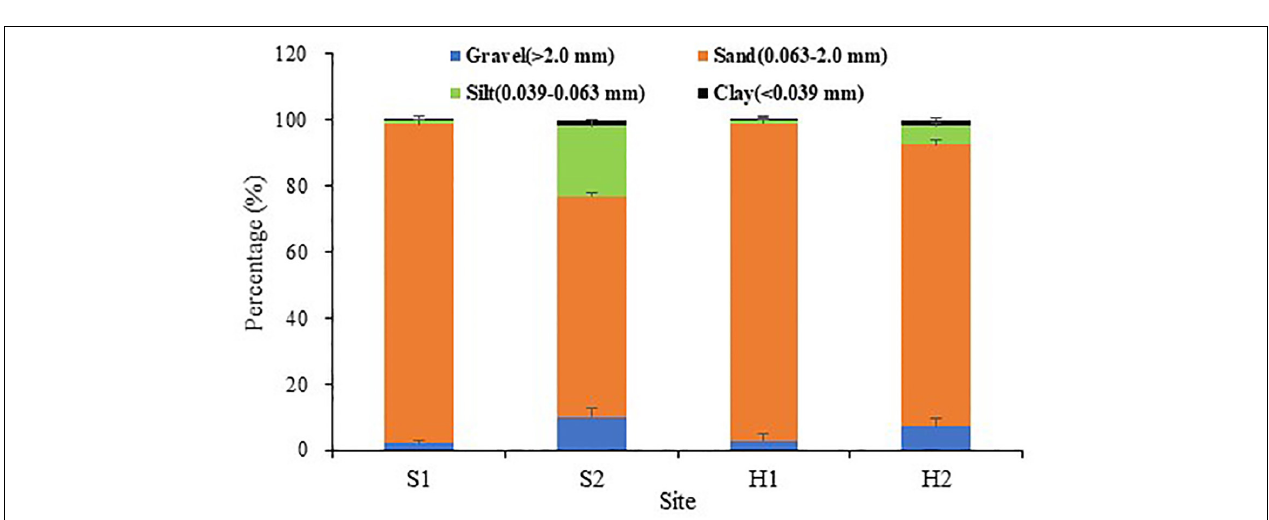
FIGURE 3 | Sediment grain sizes at the four study sites. Values are mean ± SD ( N = 3 cores per site).